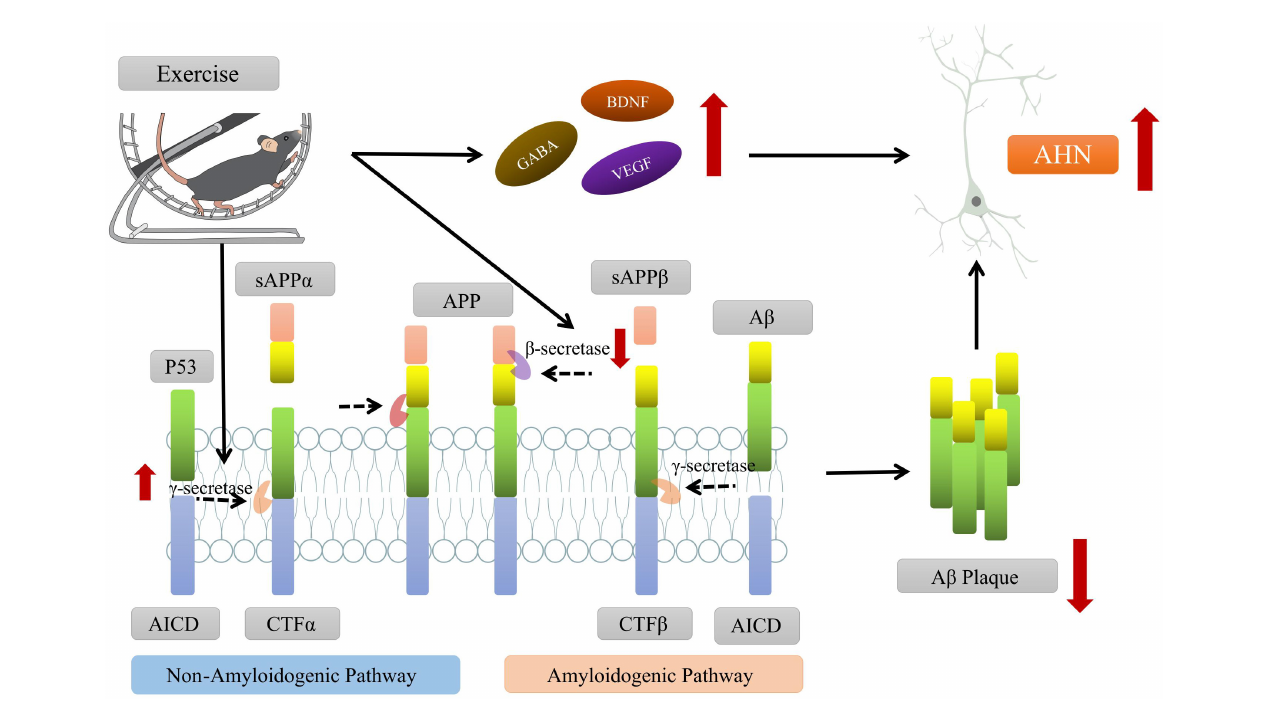
FIGURE3 Exercise promoting the adult hippocampal neurogenesis (AHN) and improving the cognitive function of AD mice. On one hand, exercise intervention can promote the cleavage of amyloid precursor protein (APP) by affecting the levels of key secretory enzymes (such as β -secretase, γ -secretase, etc.) and reduce the aggregation of A β in brain. On the other hand, exercise can regulate the levels of neurotrophic factors (such as BDNF, VEGF, etc.), create a microenvironment conducive to AHN, and promote the survival and differentiation of new neurons. Some of this illustration was started from a Scidraw